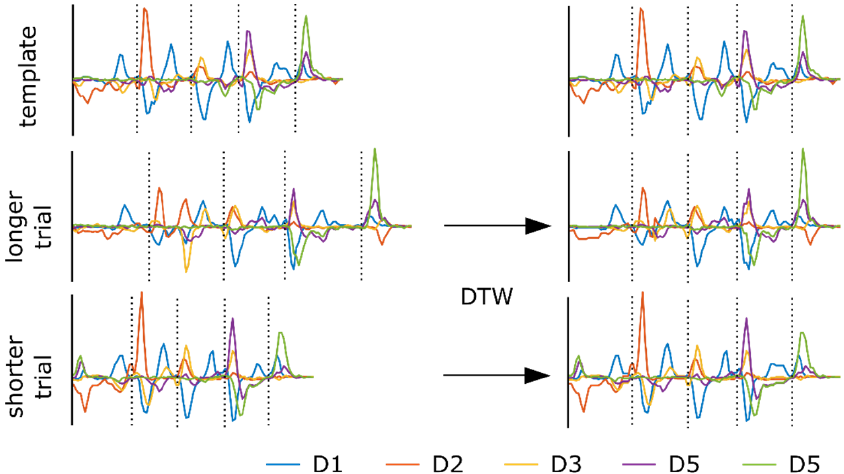
Figure 2. Signal synchronization utilizing dynamic time warping (DTW). For simplicity, we show only J2 angular velocities of fingers D1–D5 for two exemplary trials of the small Rubik’s cube task (cw), one longer and one shorter than the template trial. The resulting time series are sampled to the length of the template and have a minimum sum of Euclidean distance to the template. As the vertical dotted lines in each plot show, the different segments of the signals are asynchronous before DTW and are synchronous after DTW.